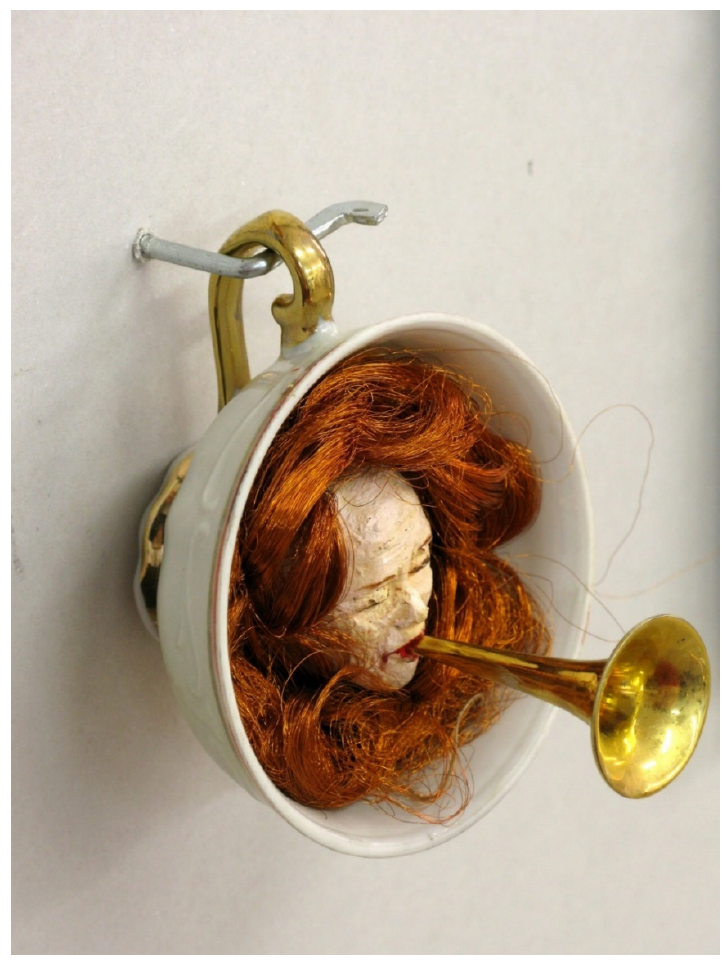
Figure 3. Dvora Morag, “Mom?”, 2013. Mixed Media. Photo: Avi Amsalem.